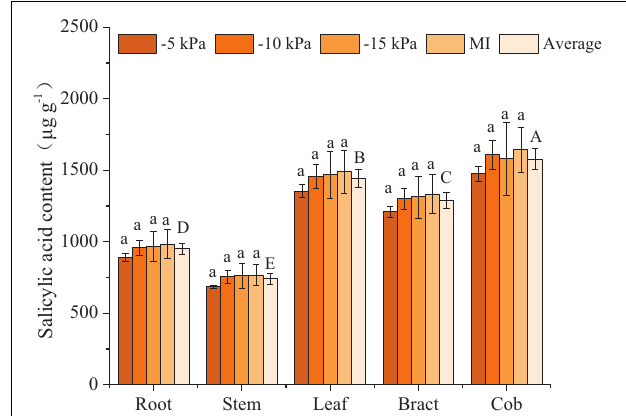
FIGURE 5 | Salicylic acid content in different organs of maize under different treatments. Values represent mean ± SD. The least significant difference method was used to test differences among treatments or organs at the P < 0.05 level. Different lowercase letters indicate significant differences among treatments within the same organ, and different capital letters on the average value of all treatments in each organ indicate significant differences among